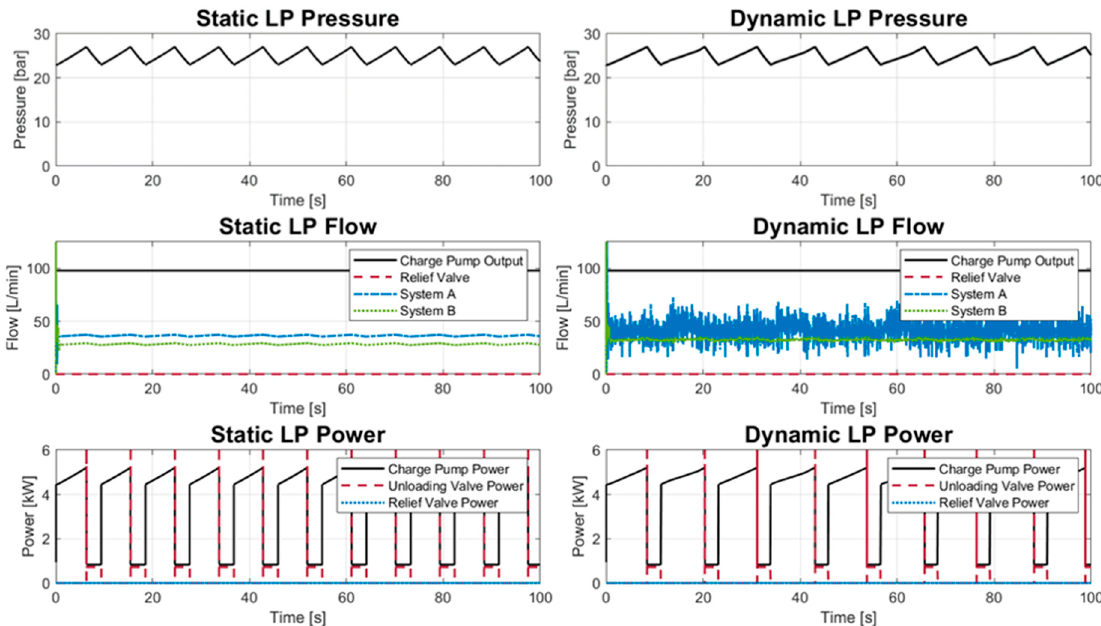
Figure 14. Proposed ASPU LP system results of both static and dynamic operating conditions.